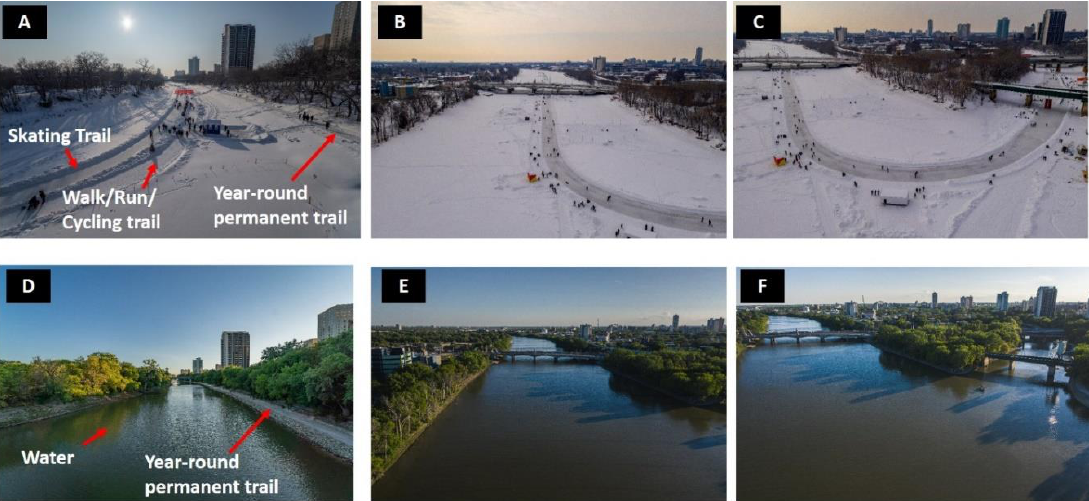
Figure 1. Visual evidence that the intervention consisted of walking (running, skating, and cycling) on water. A-C: Representation of the frozen waterway at different segments (A) Assiniboine River Heading South; (B) Red River heading south; (C) Red and Assiniboine River Junction. D-F: Representation of the same points along the waterway in July 2019 providing evidence that the trail network was created on